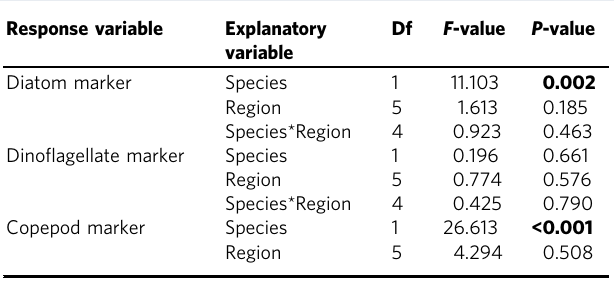
Table 2 Statistical results of fatty acid markers between krill and salps.